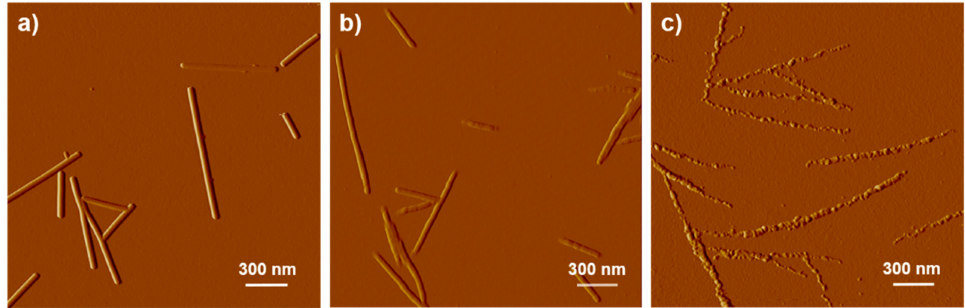
Figure 1. AFM amplitude images of: ( a ) TMV-Cys virus particles, ( b ) TMV-Cys incubated in N,N-dimethylacetamide (DMAc) for 30 min and ( c ) TMV-Cys reacted with poly(pentafluorostyrene) (PFS) in DMAc for 30